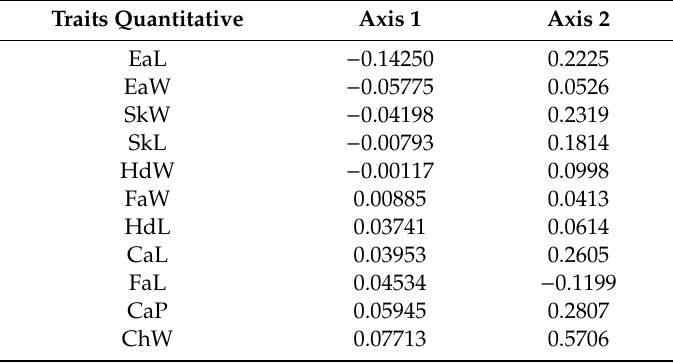
Table 2. Loading values for Principal Component 1 (PC1) explained 93.9% of the total observed croup height (CrH), and dock height (DoH) were the most discriminative traits for PC1 (values >